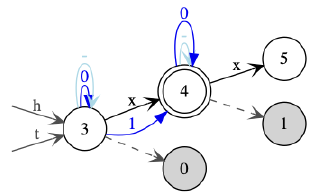
Figure 23. A single x -marked